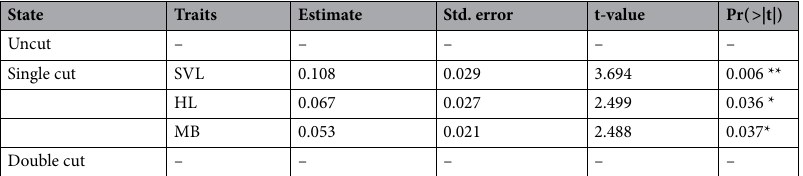
Table 1. Effect of morphology on the maximum sprint speed under three states estimated using PLS. Estimate represents the regression coefficients for the traits on speed. The standard error of the estimate (Std. Error), t values and probabilities (Pr( >|t|)) were estimated using the jack-knife procedure in the pls package of R. Significance levels: * P < 0.05, ** P < 0.01.